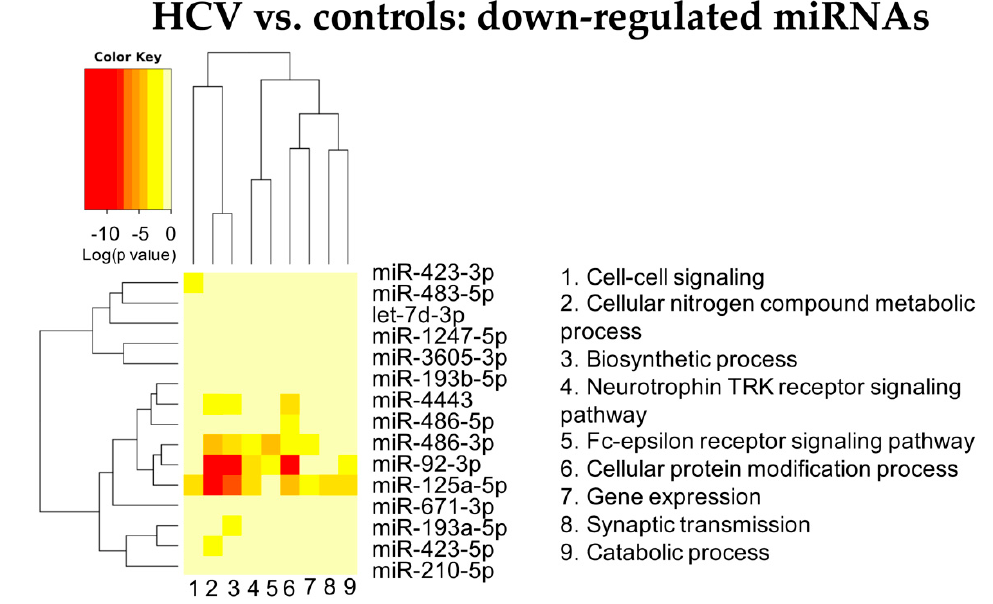
Figure 3. Heatmap showing the significance (see color key) of the association of down-regulated miRNAs with “Gene Ontology-Biological Process” categories, as identified applying the “Categories Union” method.